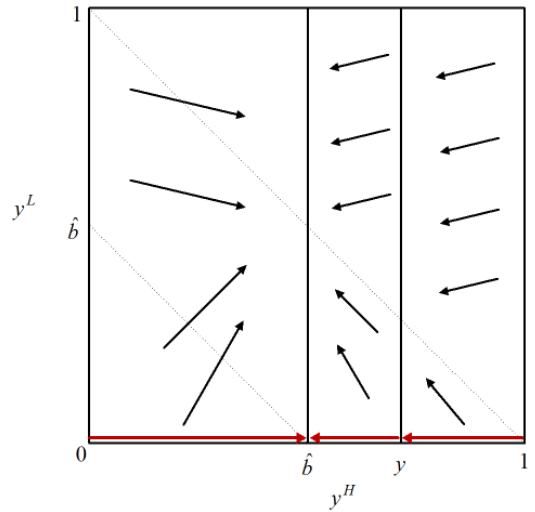
Figure 2. The Monopoly Equilibrium I.